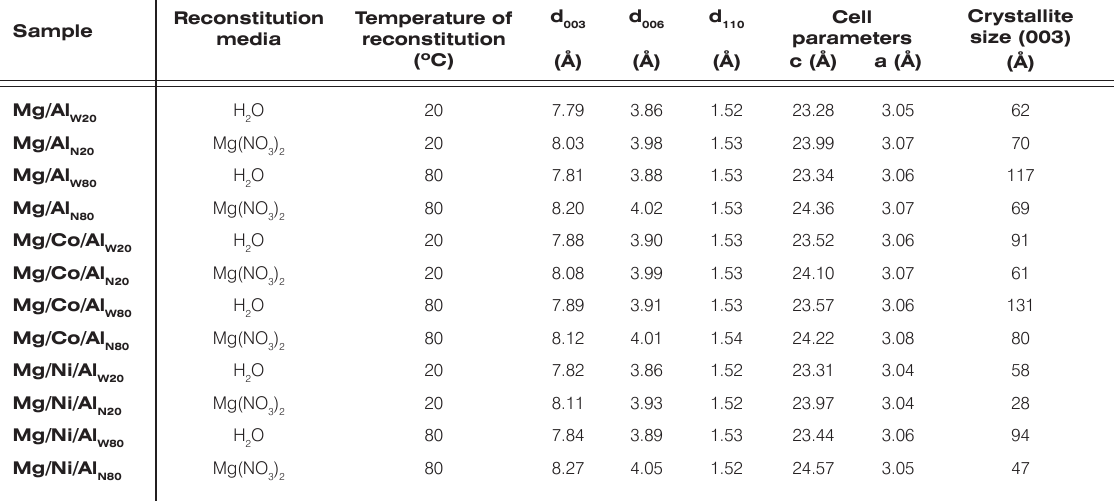
Figure 2. Thermogravimetric (solid line), differential thermogravimetric (dots line) and differential scanning calorimetric (dashed line) curves of synthesized LDH: A- Mg/Al ; B- Mg/Co/Al ; C- Table 3. Crystallographic data and crystallite size of regenerated layered double hydroxides.